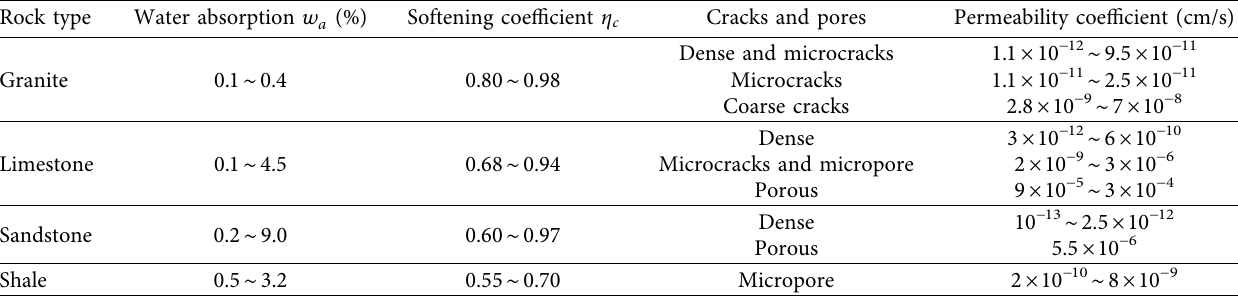
Table 5: Water-physical properties of common rocks.